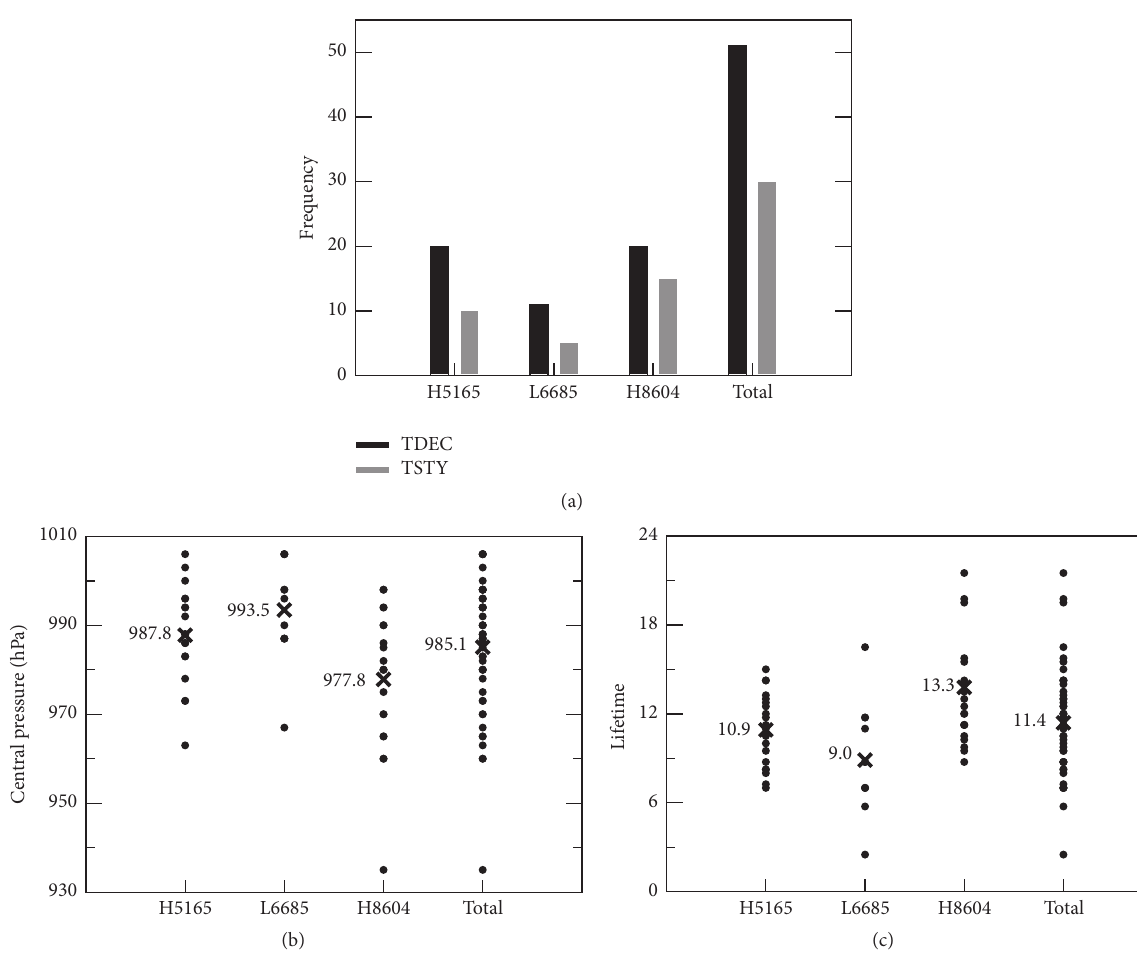
Figure 2: The (a) frequency, (b) central pressure at landfall, and (c) lifetime of the Korea-landfall TC in each period. × marks in central pressure and lifetime denote averages in each period.